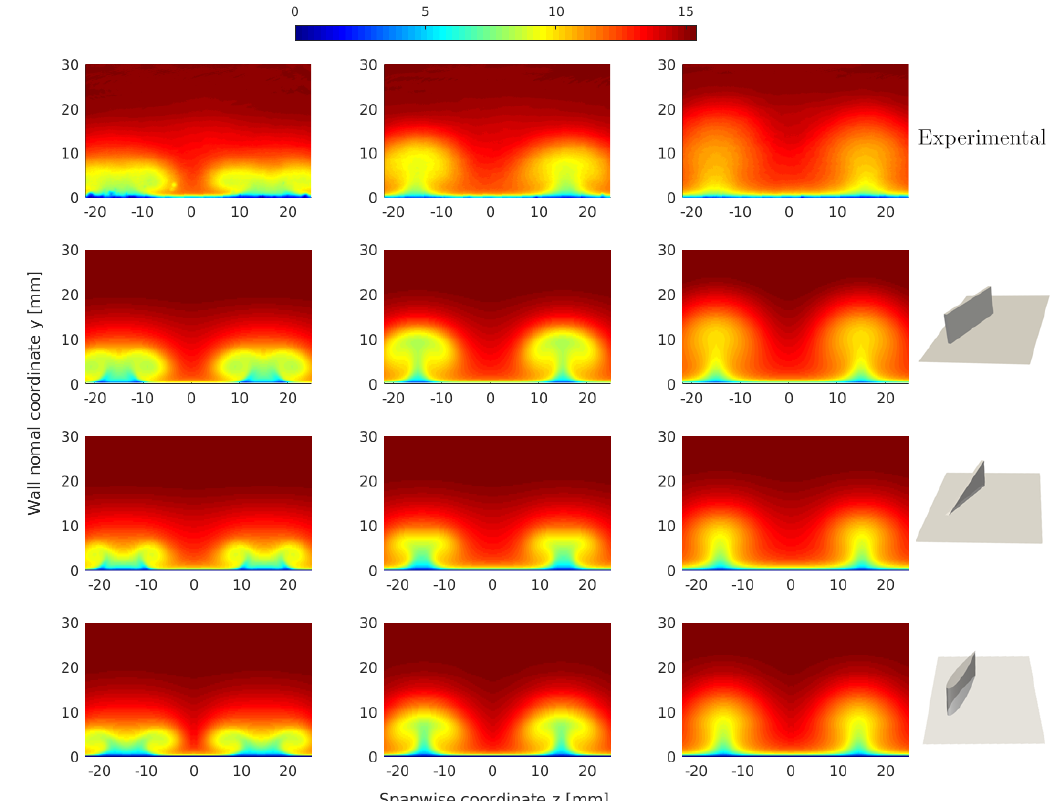
Figure 9. Comparison of the out-of-plane streamwise velocity fields u x between experimental data for Rectangular VG case ( top ) and numerical simulations of three VG geometries ( from second row to fourth ). Streamwise plane positions from left to right: 10H, 25H,